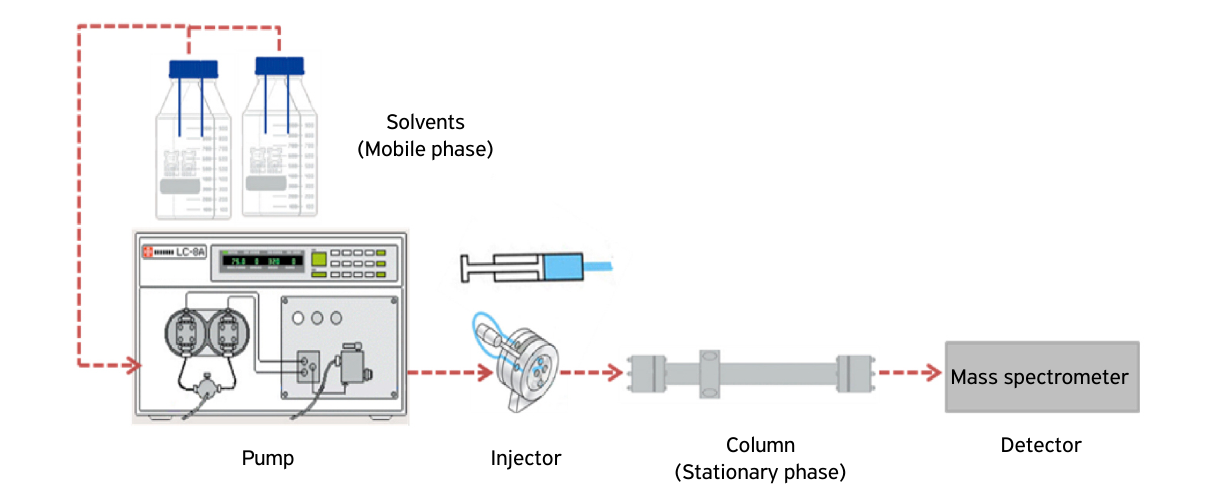
Figure 1. Diagram of the liquid chromatography